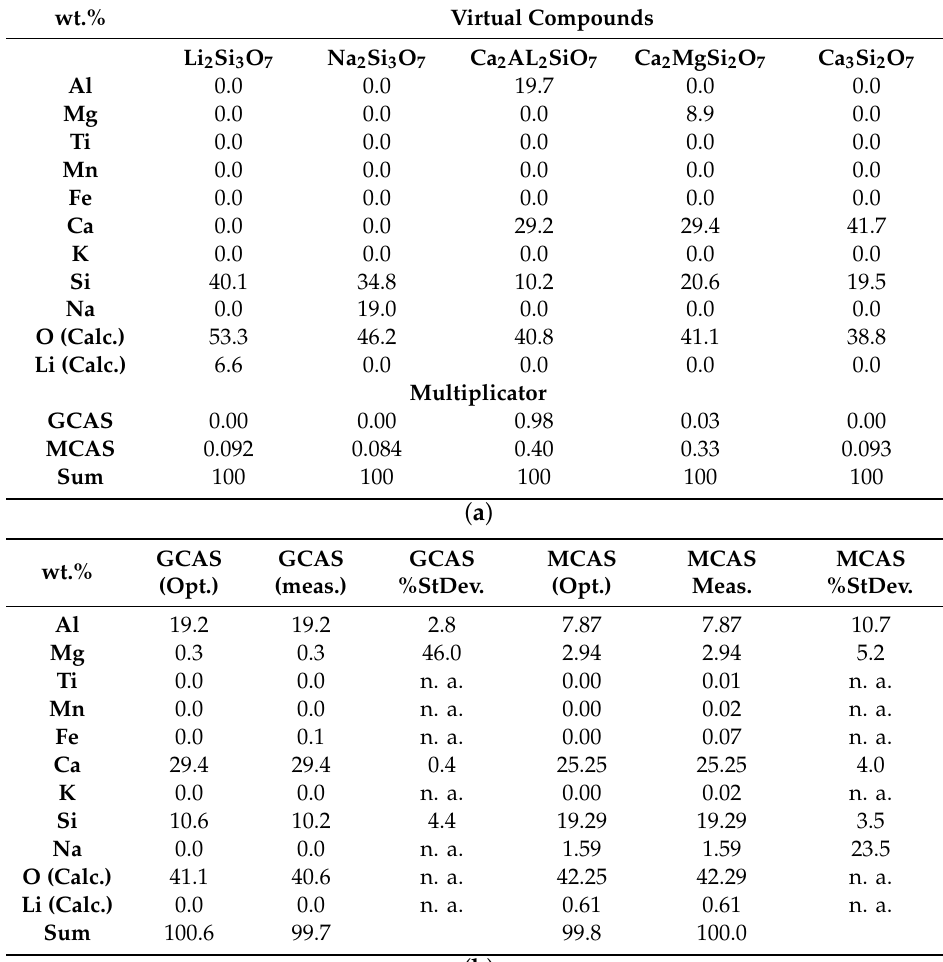
Table 6. ( a ) Multiplication Factors (Mult.) for Calculation of an Optimized GCAS and MCAS. ( b ) Average Composition of the GCAS and MCAS Ca-Alumosilicate Solid Solution in Single Point Analysis, Compared with the Optimized Compounds Calculated with the Factors of Table 6a. Opt., Calculated Ideal Composition; Meas., Measured Average; (Calc.), Calculated Values (Li, O); %StdDev, Percentage Standard Deviation of the Measured Points (Repeats, n = 7 (GCAS), n = 6 (MCAS)). wt.%